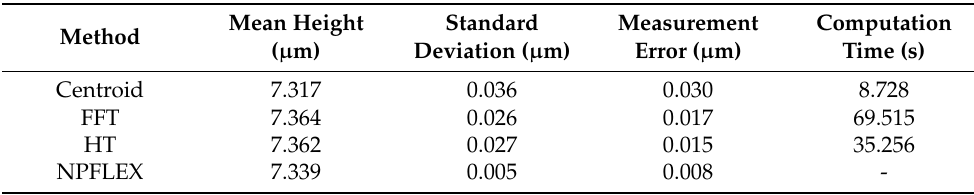
Figure 12. Comparison of mean heights and standard deviations of 47.022 µ m step height at different positions. Table 2. Measurement results of 7.347 µ m step height.